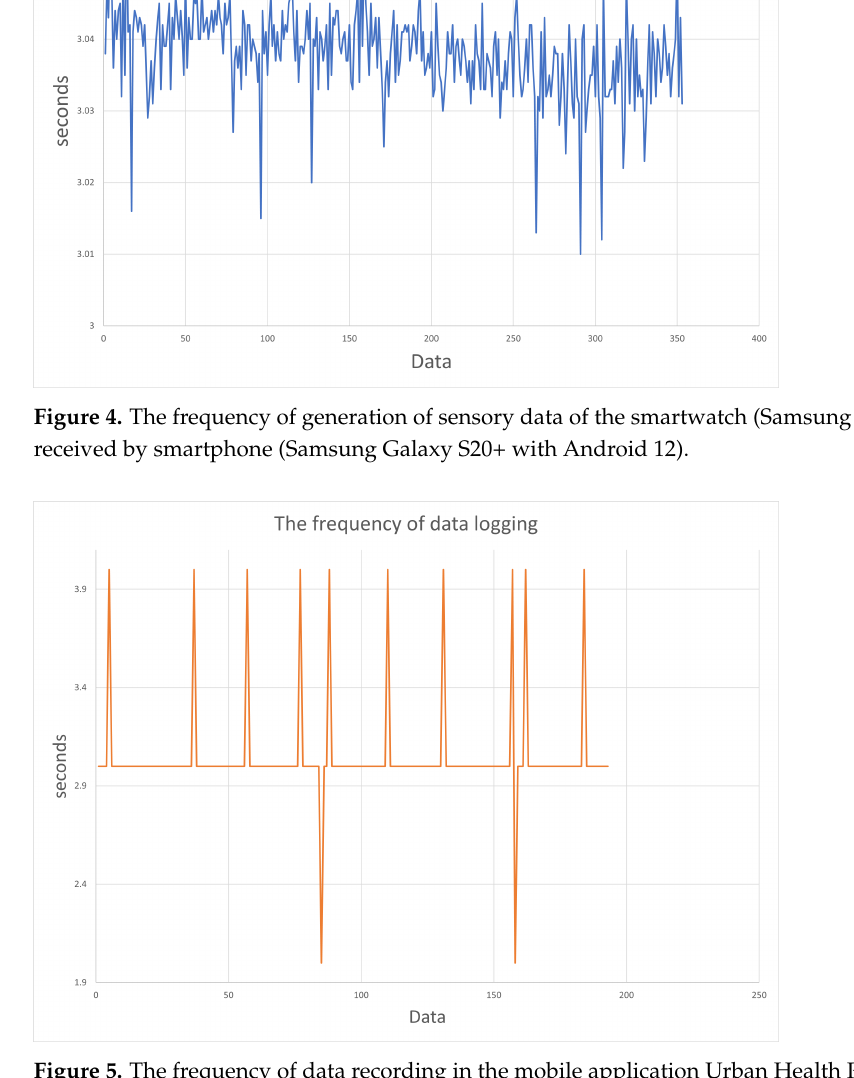
Figure 5. The frequency of data recording in the mobile application Urban Health